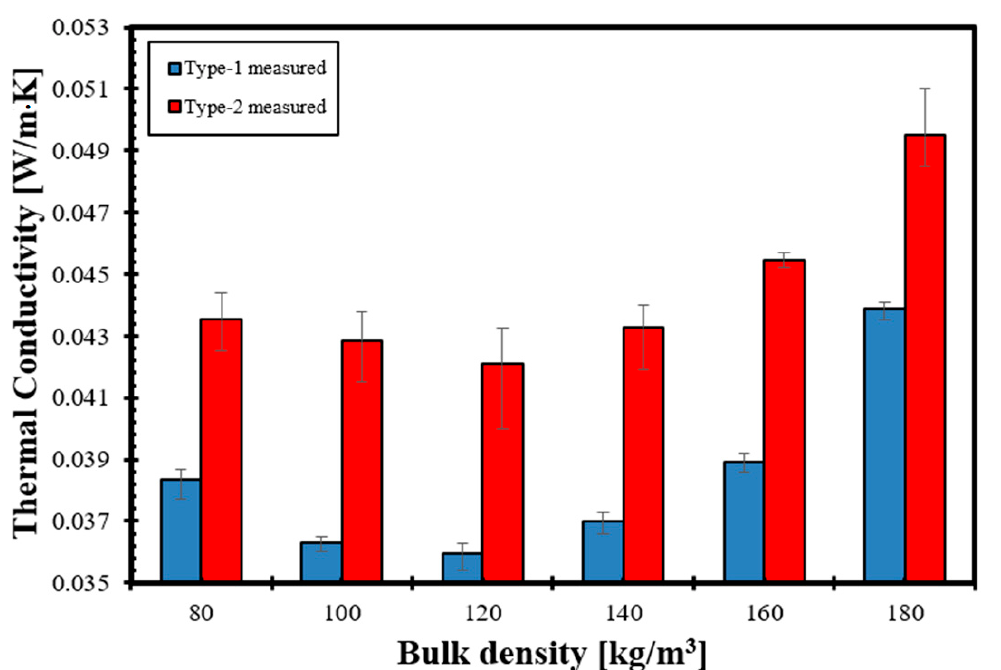
Figure 9. Measured thermal conductivity of randomly oriented Type-1 and Type-2 straw bulks with different bulk densities.